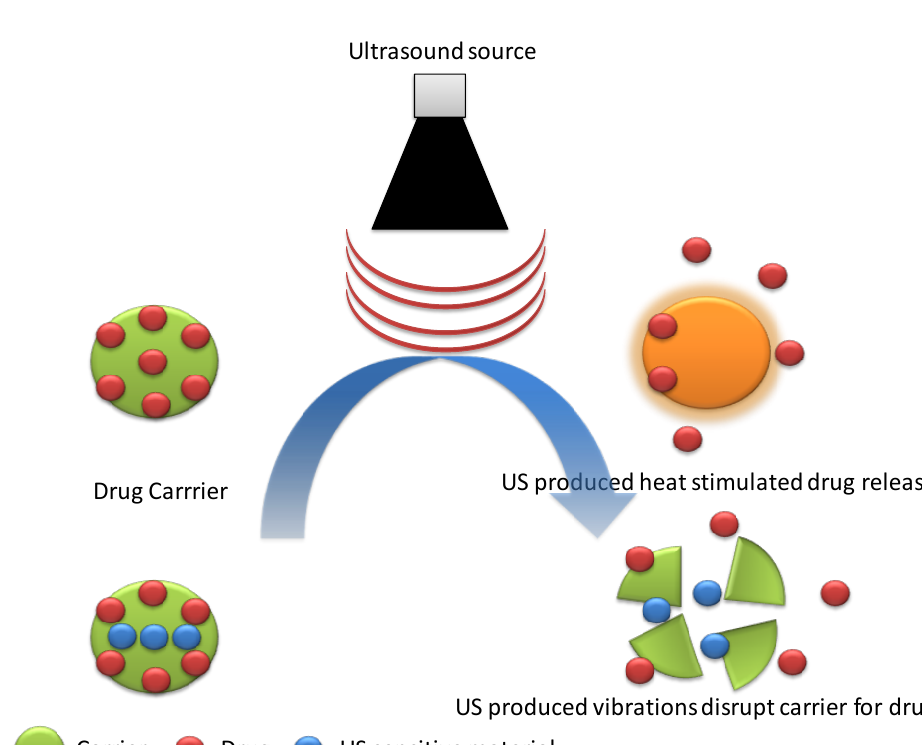
Figure 10. A schematic presentation of ultrasound responsive drug release through heat stimulation and US-induced vibrations.